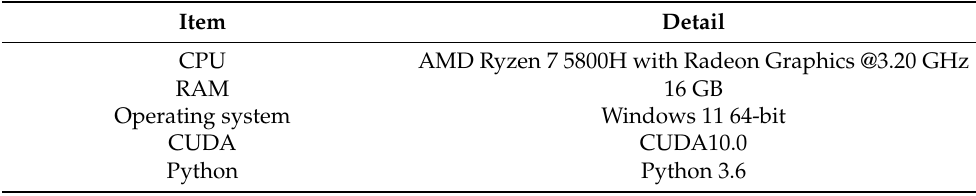
Table 2. Experimental software and hardware configuration.